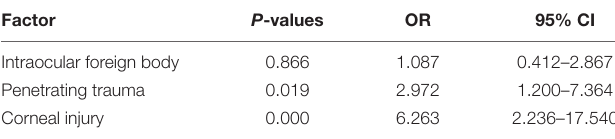
TABLE 3 | Univariate analysis of risk factors for evisceration in patients with OC.